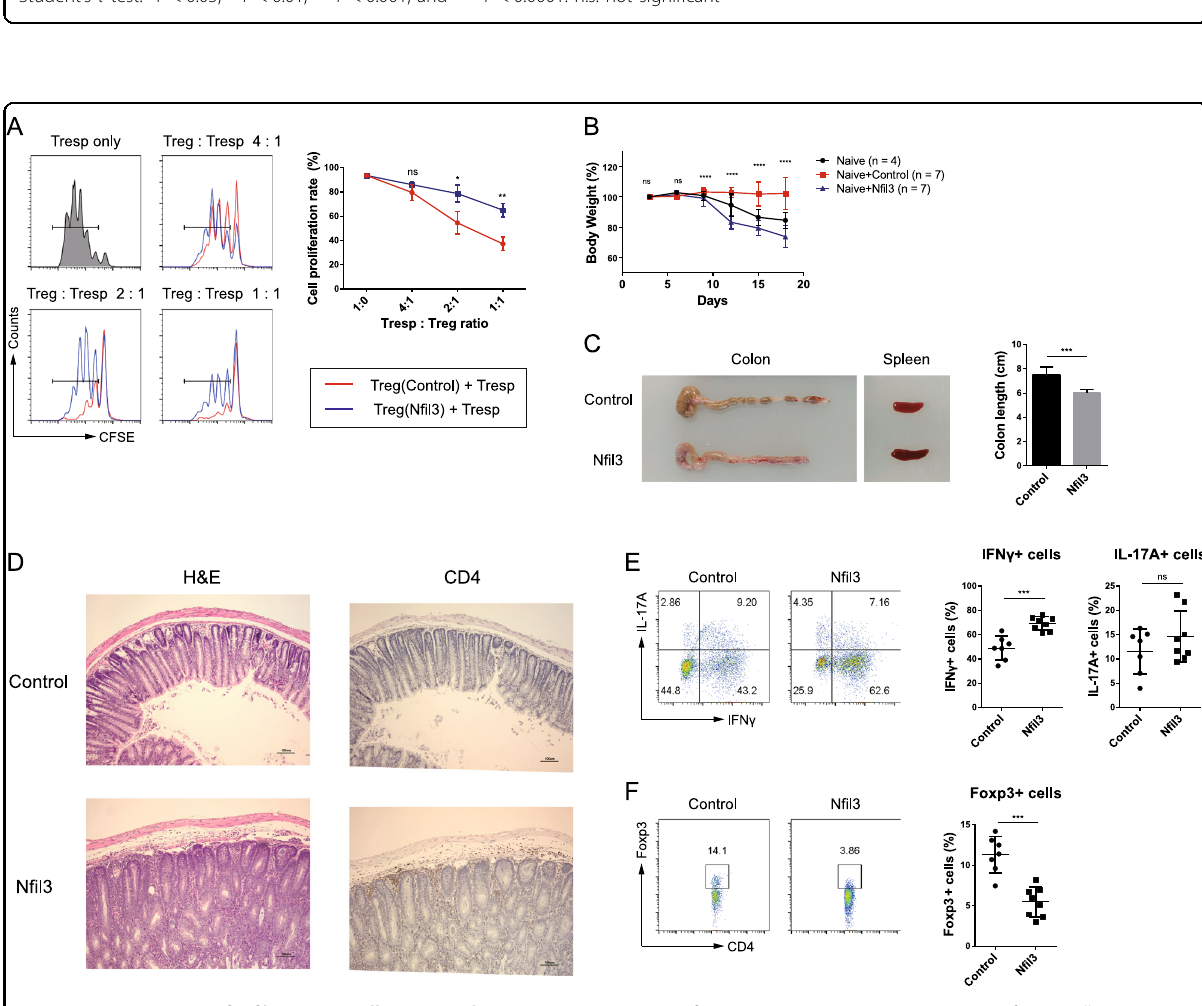
Fig. 8 Overexpression of N fi l3 in Treg cells impairs their immunosuppressive function. In vitro suppression activity of Treg cells was determined by measuring the proliferation of CD4 + CD25 − Tresp cells. Cells were transfected with control or N fi l3 vector, as previously described, and GFP + cells were sorted. Sorted cells were mixed with CFSE-labeled responder T (Tresp) cells at various ratios and cultured in the presence of anti- CD3/CD28 beads for additional 3 days. Tresp cells were selected and analyzed by fl ow cytometry. Representative fl ow plots from three independent experiments (left panel) and cumulative data, n = 3 (right panel). b – f Transfer-induced colitis model. Cells were prepared as for the in vitro suppression assay. CD4 + CD25 − CD62L + CD45RB hi cells and control or N fi l3 -overexpressing Treg cells were adoptively transferred into Rag1 KO mice. b The weight of the recipient mice was measured every 3 days and is presented as the percentage of the initial weight. c Representative colon and spleen morphology after 18 days. Average colon length; n = 6 – 7 (right panel). d Hematoxylin and eosin (H&E) staining (left panel) and immunohistochemistry staining of colon sections for CD4 (right panel). Brown dots indicate CD4 T cells. Scale bars, 100 μ M. Original magni fi cation, ×100. e Percentage of cytokine-producing effector CD4 T cells in the mLN. f Percentage of Foxp3 + Treg cells in the mLN. Error bars represent the SD. The signi fi cance of the differences between groups was determined using Student ’ s t test. * P < 0.05, ** P < 0.01, *** P < 0.001, and **** P < 0.0001, n.s. not signi fi